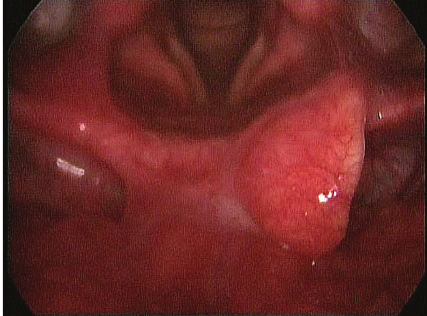
Figure 2: Appearance at 6 months